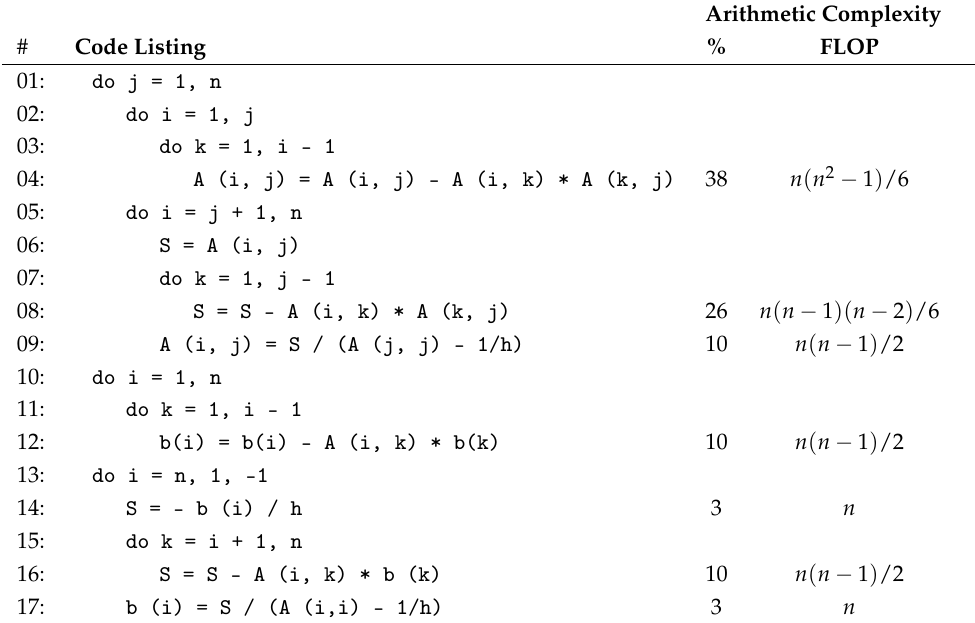
Table 1. Arithmetic complexity of the LU algorithm applied to the linear system of equations ( I − h A ) x = b of dimension n =